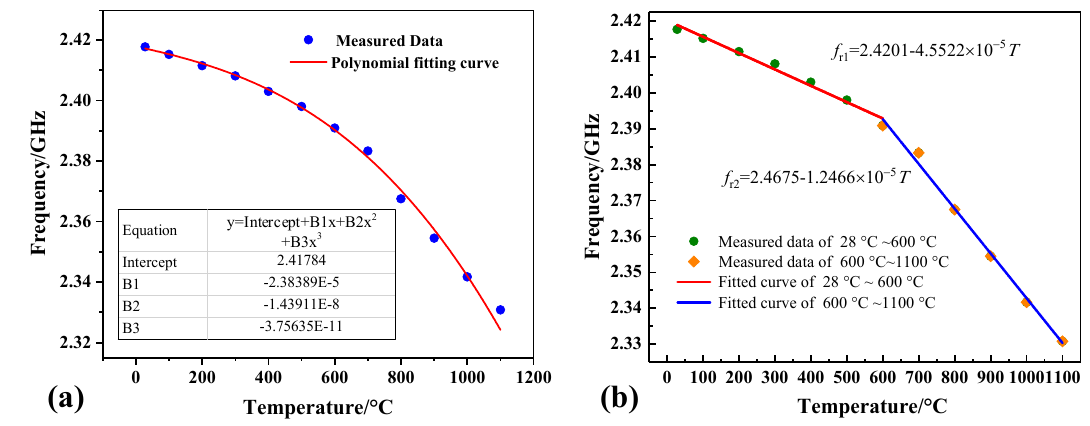
Figure 9. ( a ) Cubic fitting curve of average value of test data; ( b ) Relationship between temperature and resonant frequency polynomial fitting curves when temperature ranges from 28 to 600 °C, and 600 to 1100 °C.